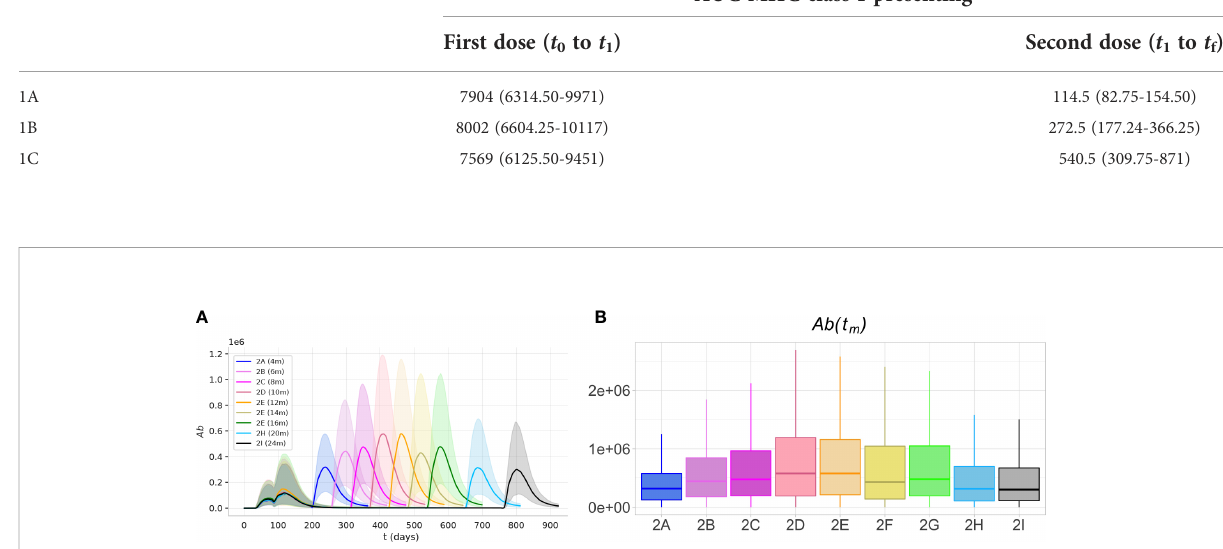
FIGURE 8 The optimal immunogenicity of antibody response to the third dose is achieved over a large time window. The protocols with intervals between the second and third dose between 6 and 16 months achieve peak antibody responses signi fi cantly higher ( p < 0.05)) than shorter or longer protocols. (A) The plots represent the dynamics of the median (solid lines) and the IQR (shaded area) of variable Ab , in experiments 2A-I. (B) The box plots show the median, IQR, and range of the antibody peak after the third dose, Ab ( t m